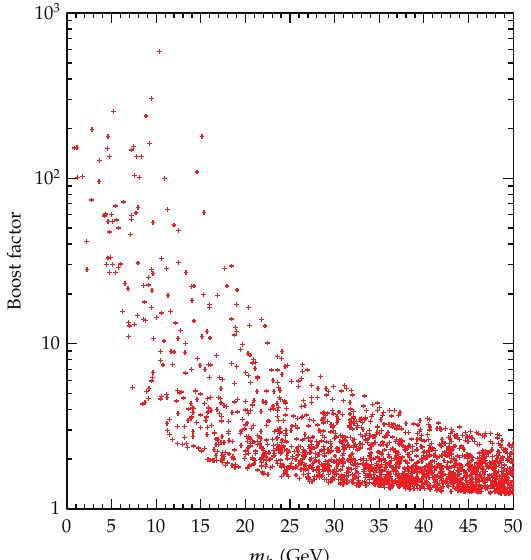
Figure 11: Same as Figure 10, but showing the Sommerfeld enhancement factor induced by h (cid:2) taken from (cid:5) 45 (cid:6)(cid:3)